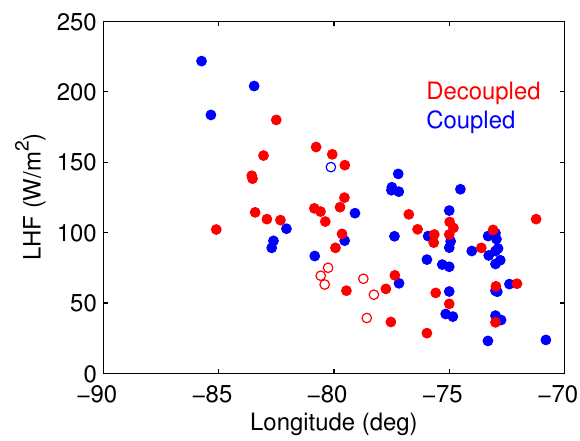
Fig. 10. Latent heat flux by longitude for each subcloud leg. Blue (red) markers indicate well-mixed (decoupled) subcloud legs. Hol- low markers indicate POC